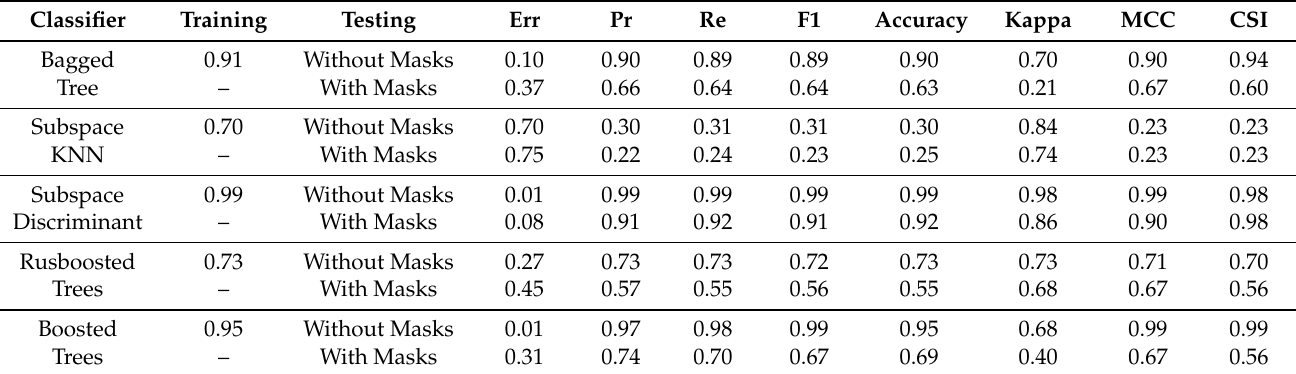
Table 2. Results of proposed method on different ensemble classifiers.